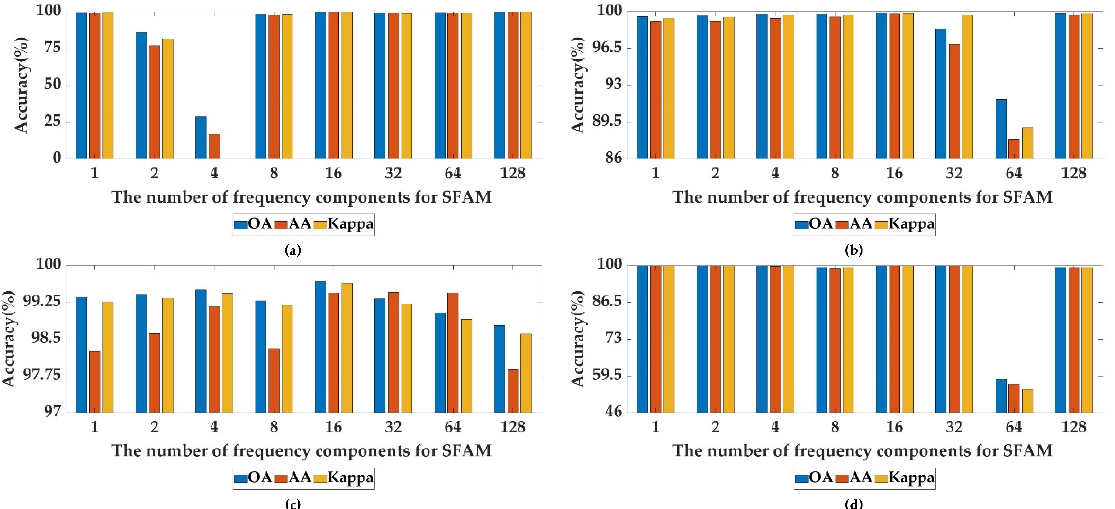
Figure 14. The classification results of different number of frequency components for SFAM. ( a ) on the SAC dataset, ( b ) on the UP dataset, ( c ) on the IP dataset, ( d ) on the SA dataset.